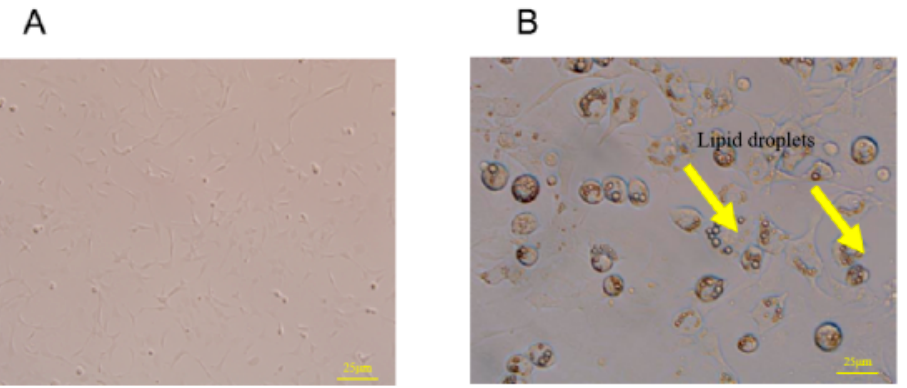
Figure 4. The comparison of 3T3-L1 adipocytes and differentiation of mature adipocytes (fluorescent inverted microscope, 10 times). ( A ) 3T3-L1 adipocytes. ( B ) Mature